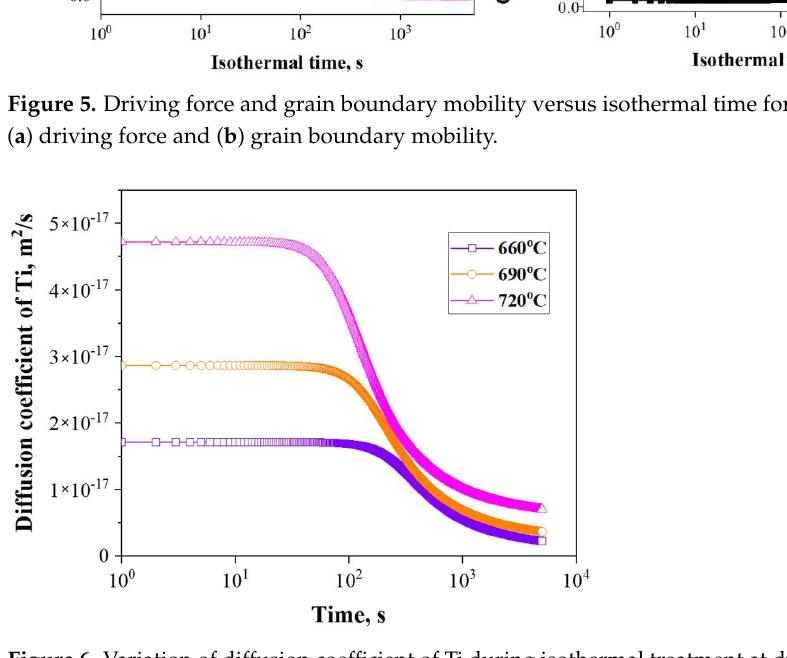
Figure 6. Variation of diffusion coefficient of Ti during isothermal treatment at different temperatures of Ti steel.